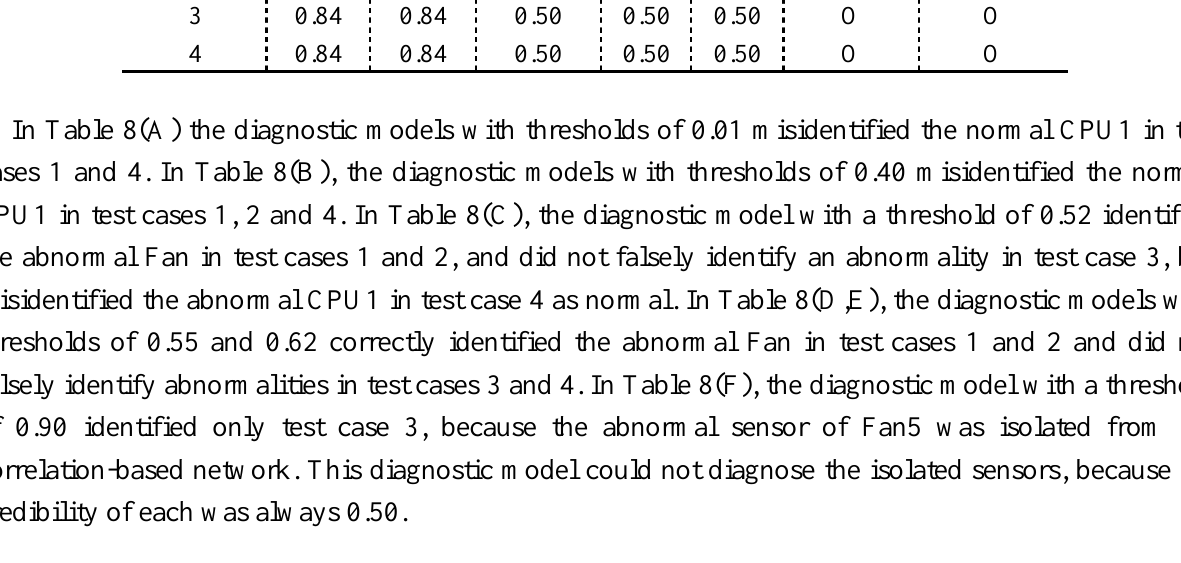
Figure 4. Example of a hybrid diagnostic model with a threshold of